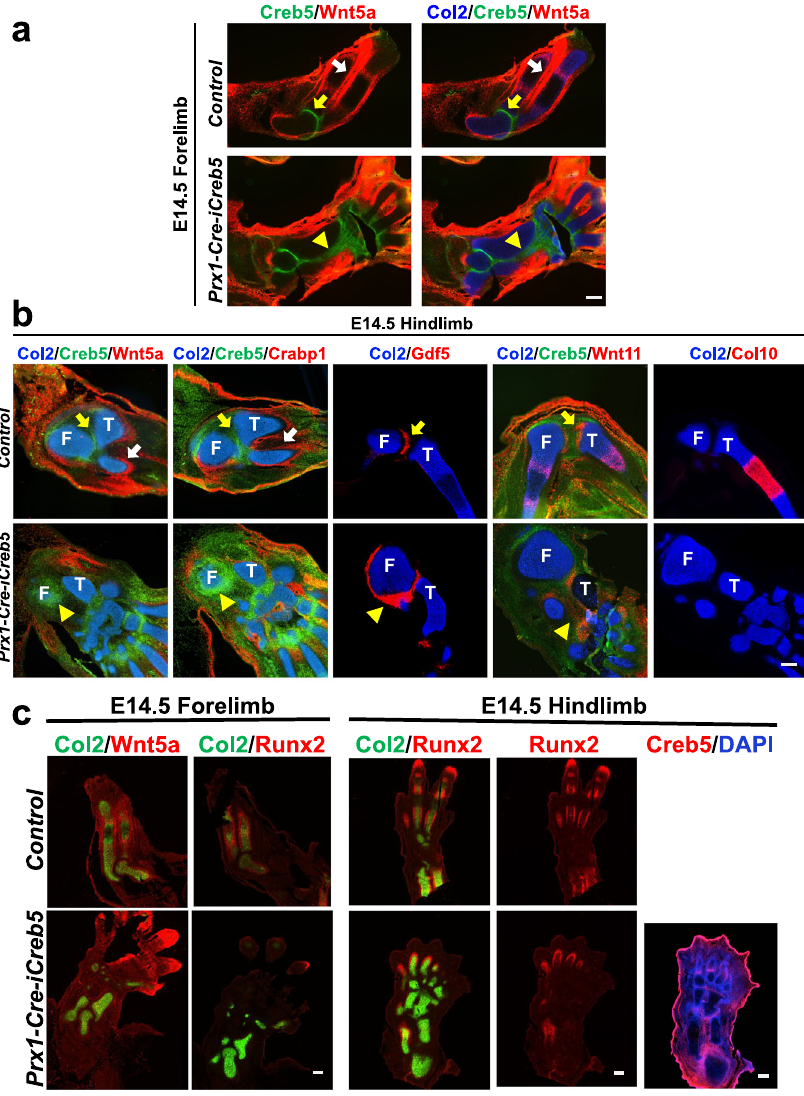
Fig. 5 | Misexpression of iCreb5-HA (Prx1-Cre) inhibits perichondrial expression of Wnt5a, Crabp1 and Runx2. Gene expression assayed by RNAscope FISH ( a , b ) or FISH( c )inserialsectionsofindicatedlimbsofeitherE14.5 Prx1-Cre-iCreb5 embryos orcontrollittermates.Incontrollimbs,thearticularperichondrium(yellowarrows) and metaphyseal/diaphyseal perichondrium (white arrows) are indicated. In Prx1- Cre-iCreb5 limbs, the iCreb5-HA (Prx1-Cre)+ , Wnt5a − /Crabp1 − perichondrium (yellow